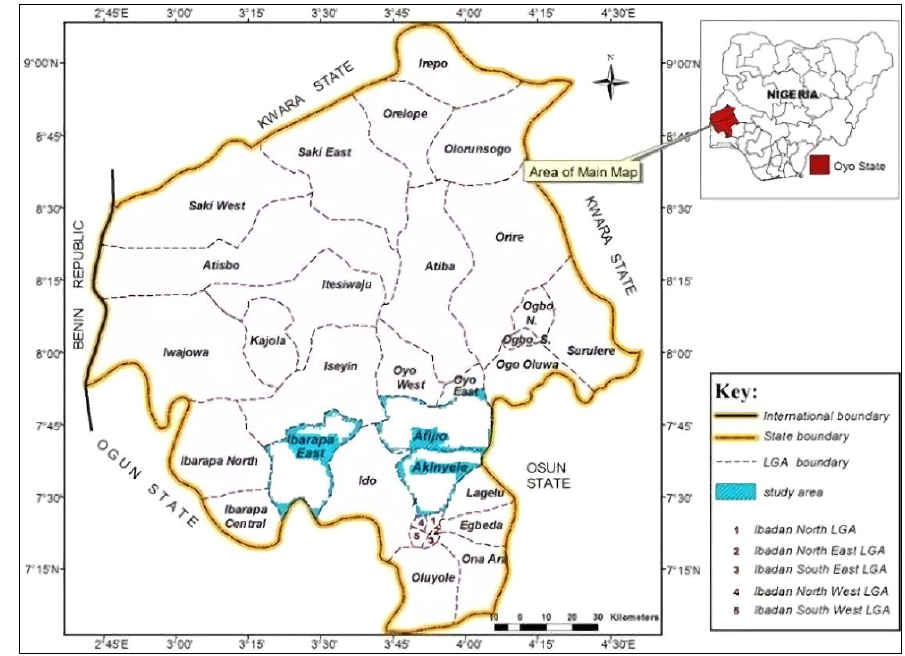
Figure 2. Map of Oyo State Showing Selected Local Government Areas